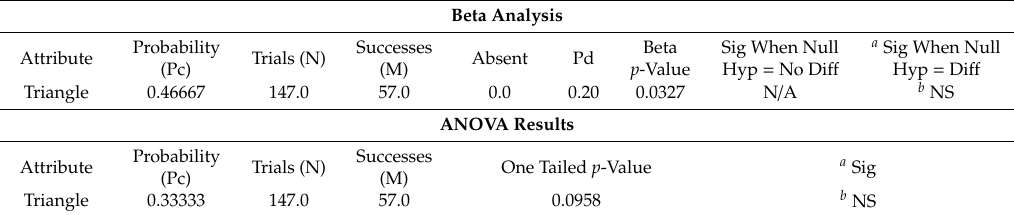
Table 4. Beta analysis results and one-way ANOVA results for sensory